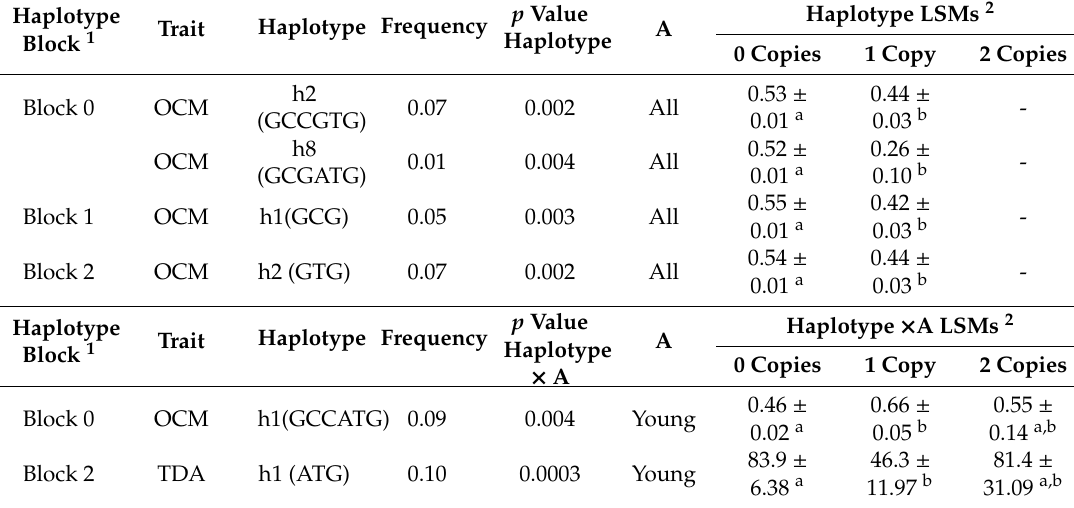
Table 4. Type III test for the haplotype and haplotype by age (A) e ff ects for blocks 0, 1 and 2 on the LEPR gene using the seasonal phenotypic data from Rasa Aragonesa ewes. The least square means (LSMs) and standard errors for the haplotype e ff ect on the LEPR gene are also shown. Only significant haplotypes after Bonferroni correction are shown. Di ff erent letters indicate significant di ff erences: a,b : p <